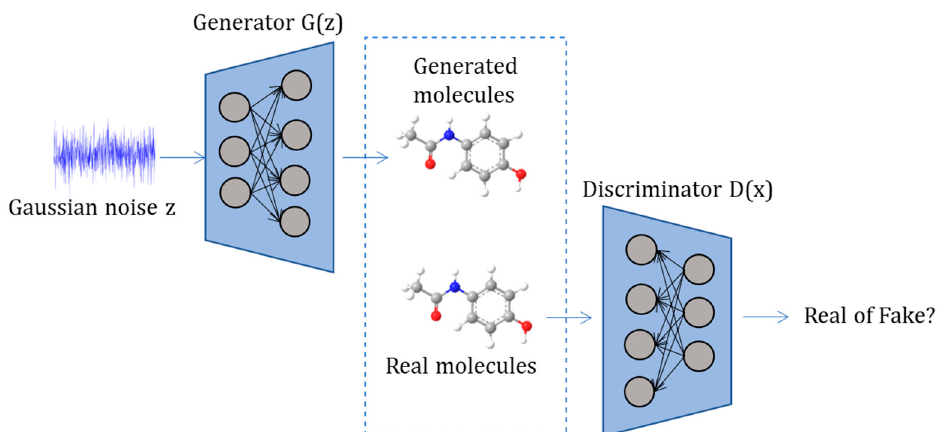
Figure 4. Generative Adversarial Network (GAN): Two independent competing networks are trained simultaneously: the Generator (G), which takes an input z from probability distribution p(z) and generates data G(z); and the Discriminator (D), which receives as input the training data or the output from the generator G(z) and tries to predict whether the input is real or generated.